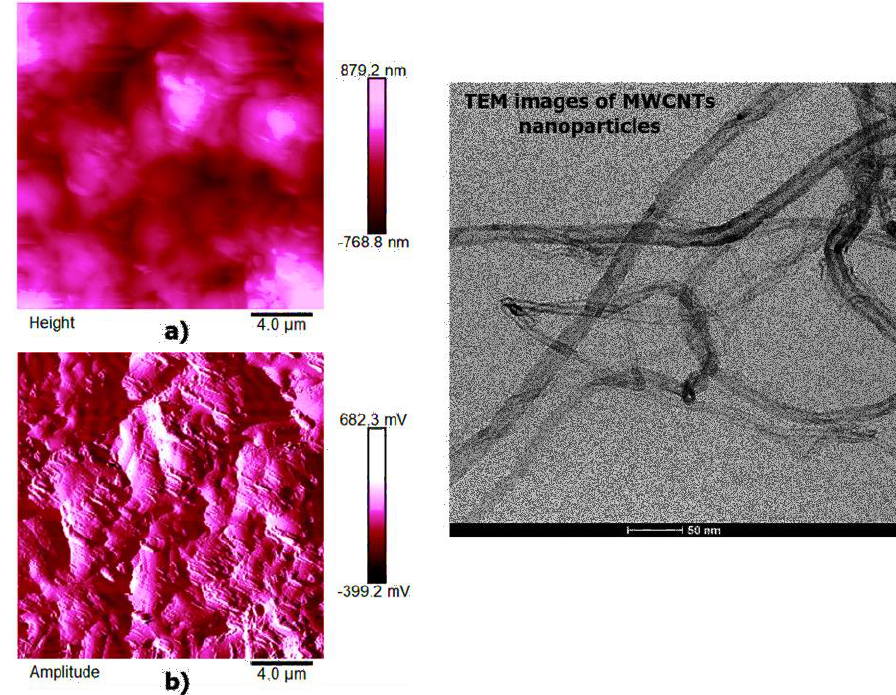
Figure 16. Tapping mode high-resolution AFM micrographs of the fracture surface of the TBD + 0.64% MWCNTs sample (see on the left: ( a ) height profile, ( b ) amplitude profile) and the TEM micrograph of MWCNTs nanoparticles (see on the right).